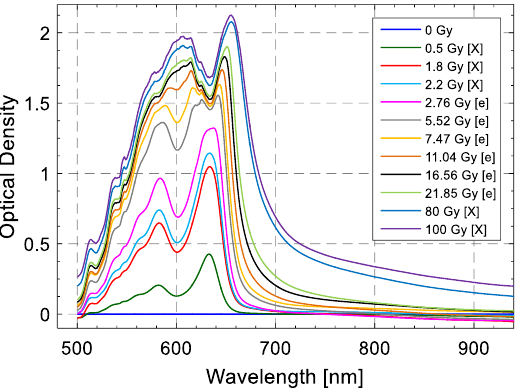
Figure 38. Average Optical Density spectra obtained upon five acquisitions from EBT3 film samples exposed to 1 MeV electron beam (referred as [e] in the legend) and to the 250 kV X-ray tube (referred